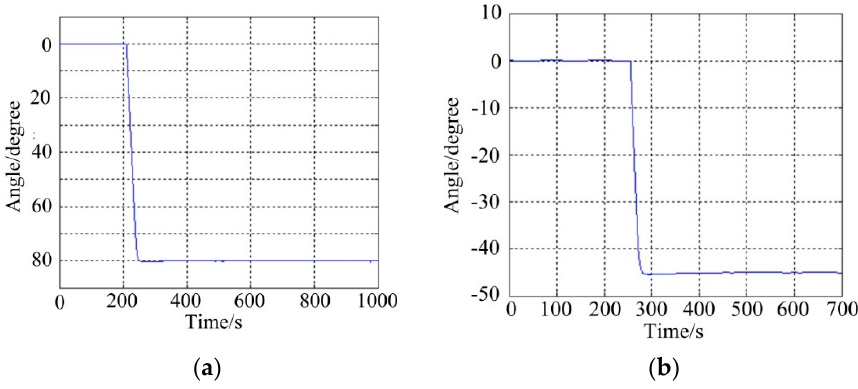
Figure 14. Stabilization results of the pitch system under static base conditions: ( a ) instruction command angle from 0° to − 80°; ( b ) instruction command angle from 0° to − 45°.